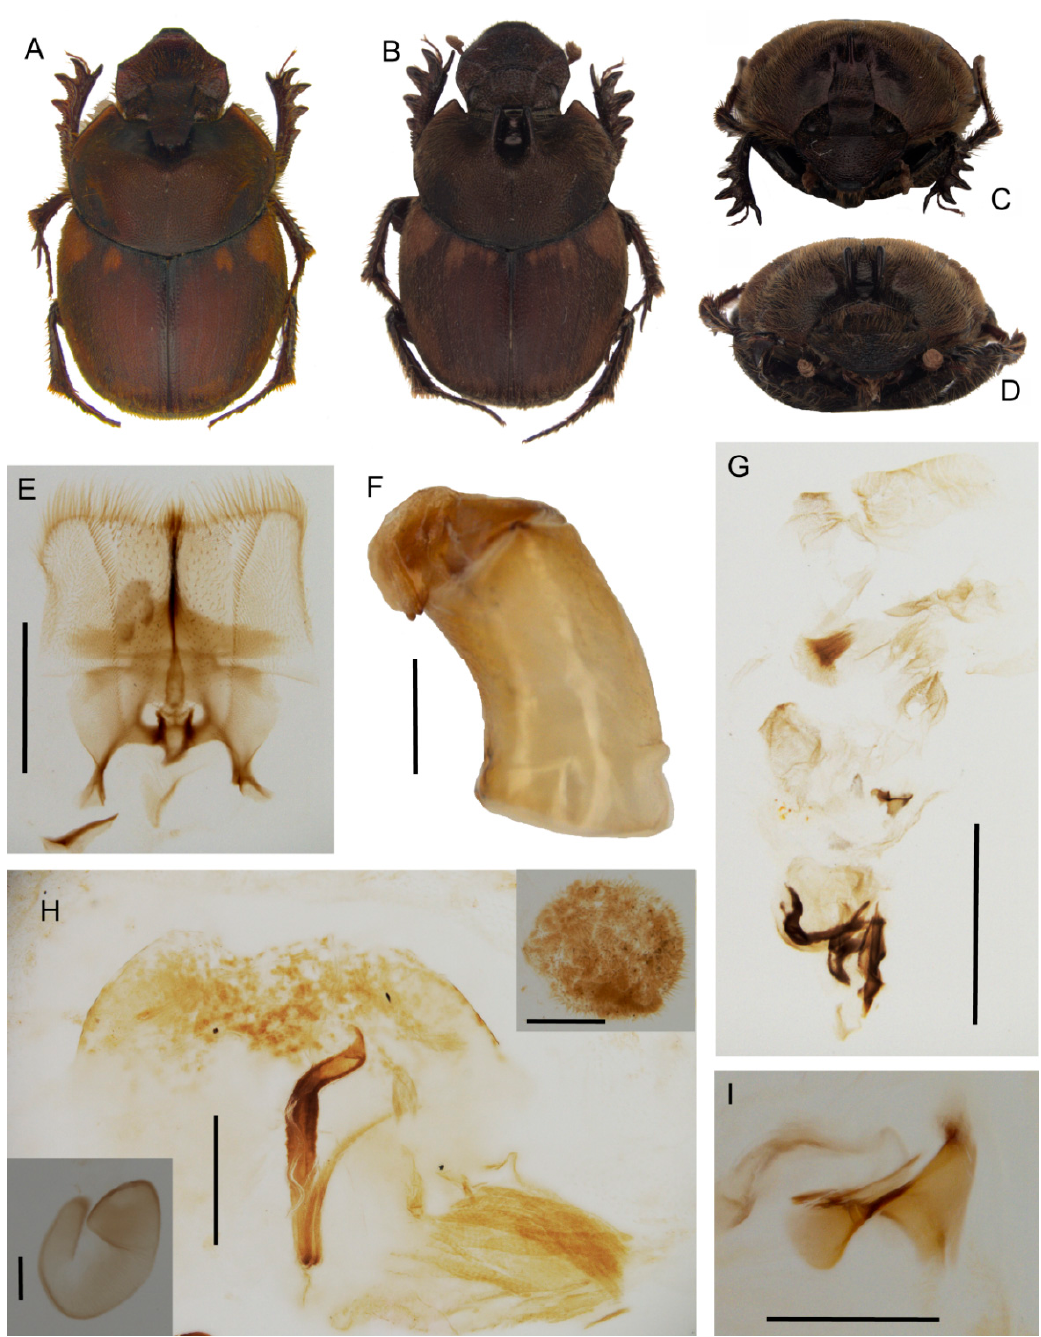
Figure 9. Features of Tiaronthophagus jossoi n.sp. ( A ): Male facies (above). ( B ): Female facies (above). ( C ): Male facies (frontal view). ( D ): Female facies (frontal view). ( E ): Epipharynx, scalebar = 0.5 mm. ( F ): Male genitalia, phallobase and parameres, scalebar = 0.5 mm. ( G ): Male genitalia, endophallus, scalebar = 1.0 mm. ( H ): Female genitalia, vagina, scalebar = 0.2 mm, with the detail of posterior expansion, scalebar = 0.1 mm, and receptaculum seminis, scalebar = 0.1 mm. ( I ): Male genitalia, lamella copulatrix, scalebar = 0.2 mm.